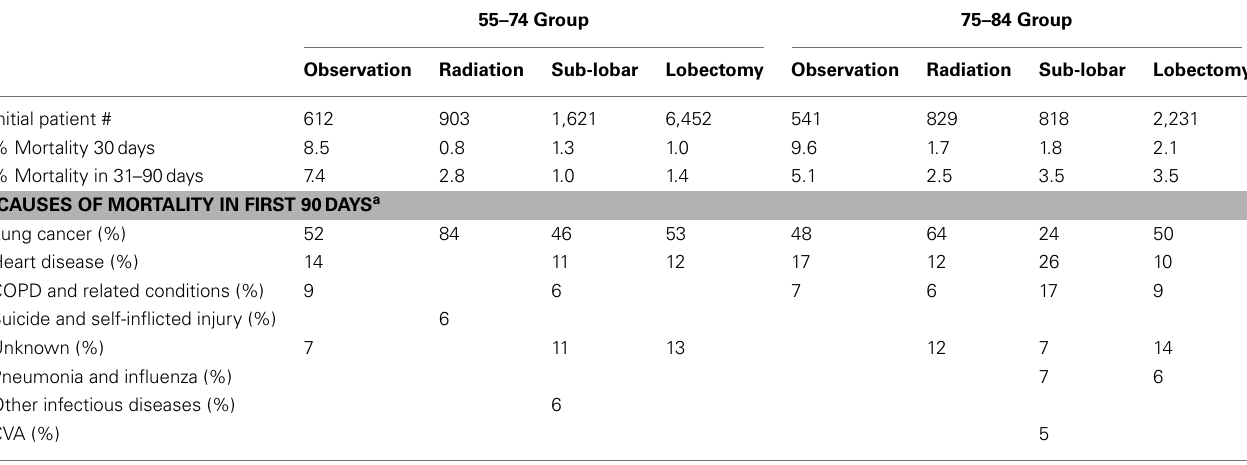
Table 5 | Mortality rates and causes of mortality within 90days of treatment